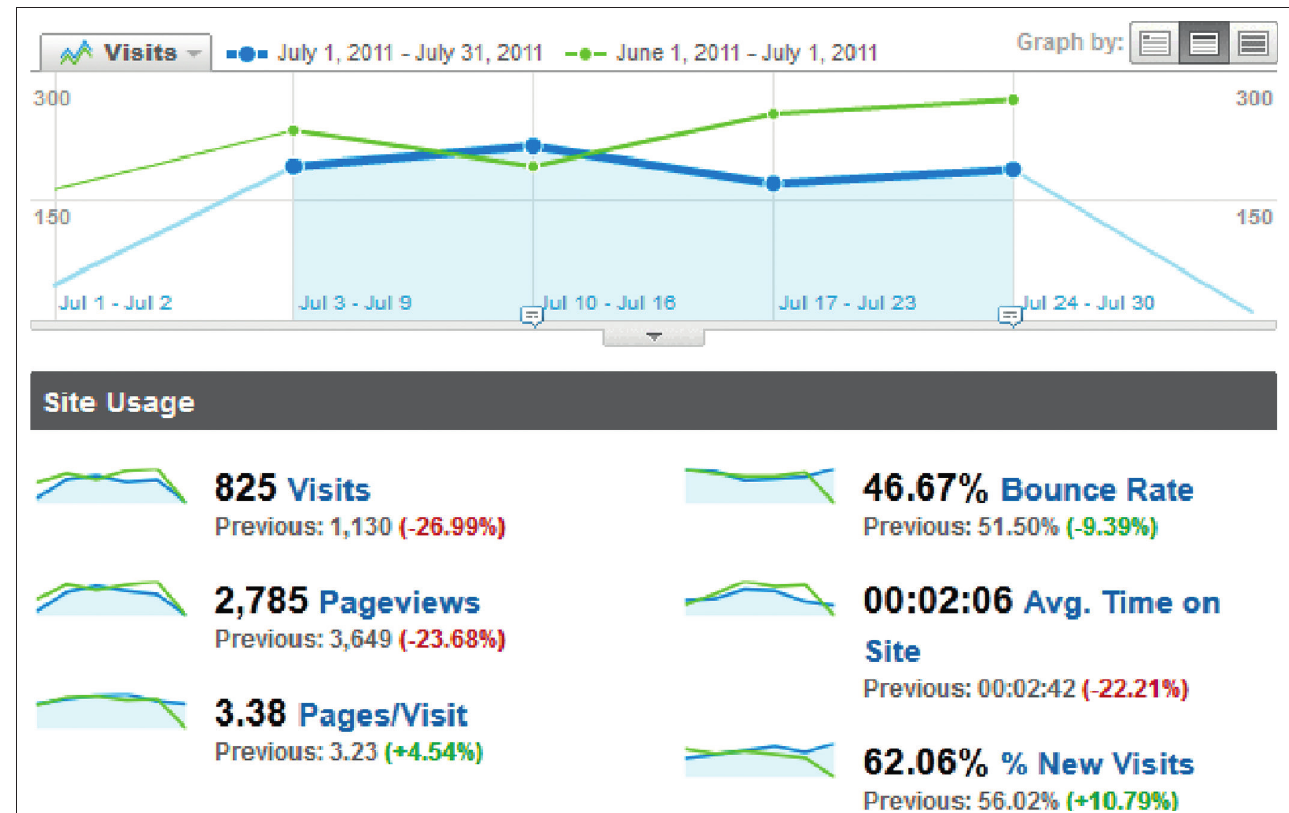
FIGURE 2: Effect of image file-name and image ALT improvement on website